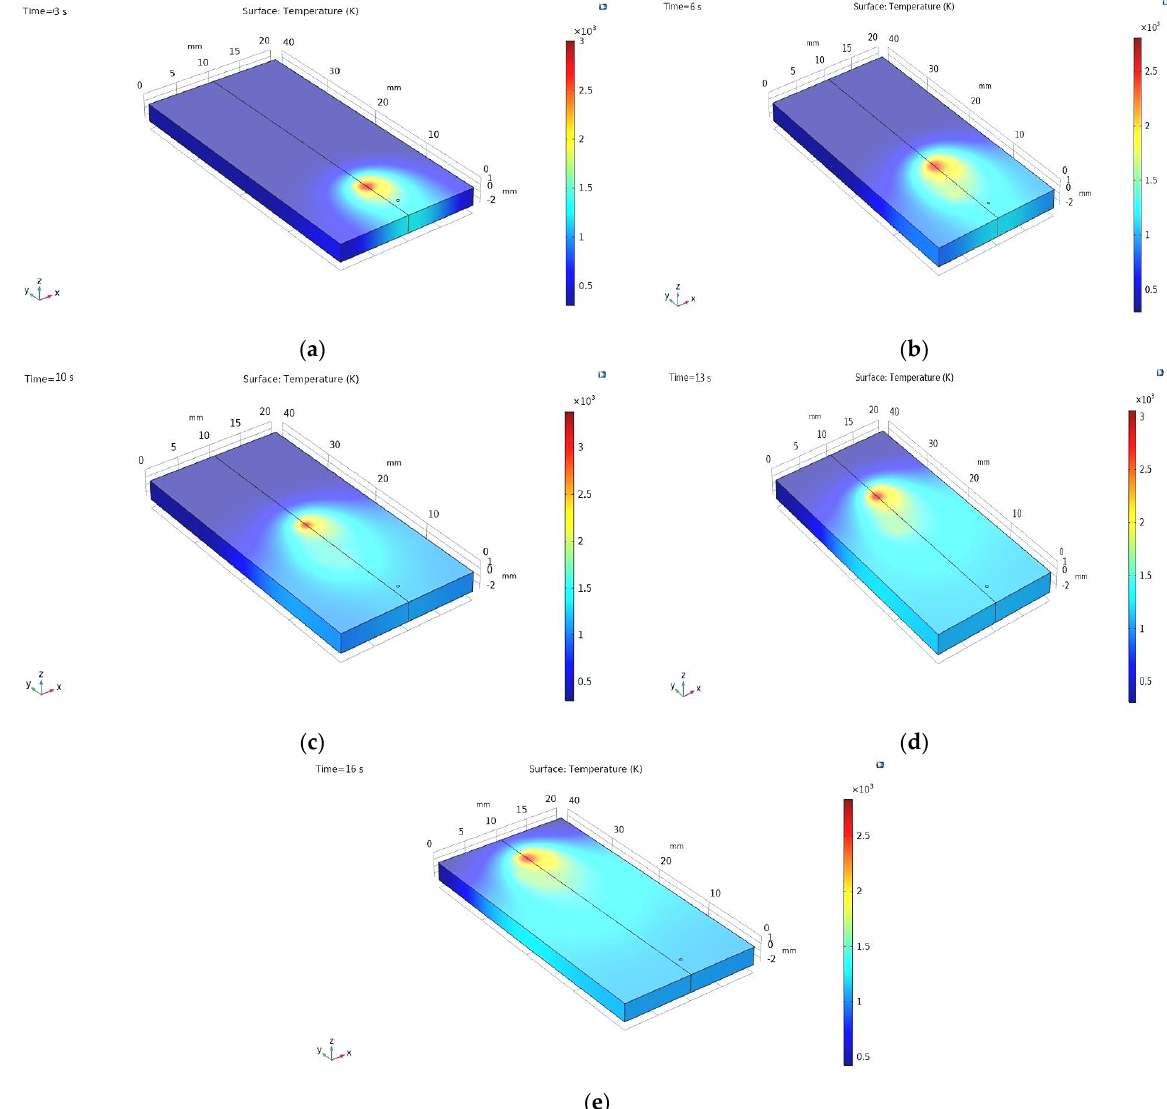
Figure 5. Temperature propagation contours at ( a ) t = 3 s, ( b ) t = 6 s, ( c ) t = 10 s, ( d ) t =13 s, and ( e ) t =16 s.